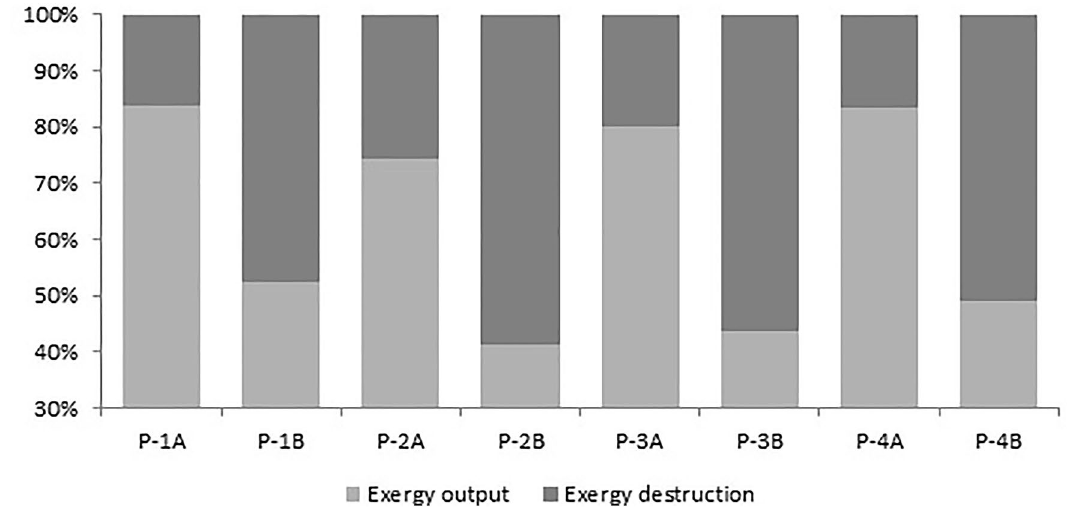
Fig. 3 Exergy destruction and exergy output